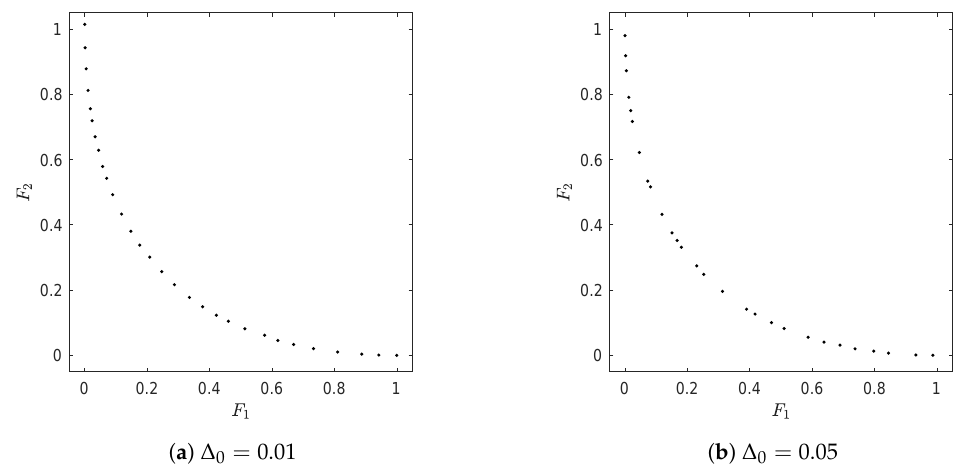
Figure 11. Results of ArchiveUpdateHD on CONV for two different initial values of ∆ using N = 30. For ∆ 0 = 0.01, the final archive contains 30 elements, while there are only 28 elements for ∆ 0 = 0.05. The solutions on the left are more evenly spread along the Pareto front due to distance considerations in the pruning technique. For the solution on the right, no pruning technique has been applied during the run of the